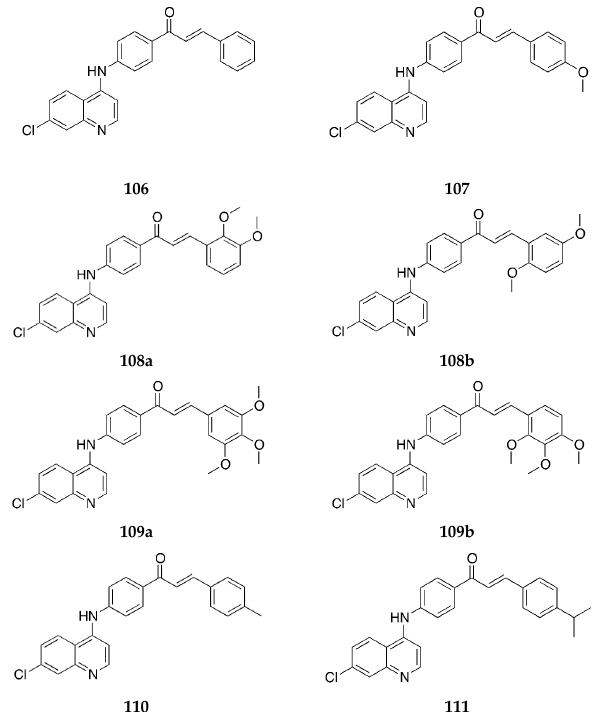
Figure 46. Chemical structures of quinolinyl-4-aminochalcones derivatives. Molecules 2020 , 25 , 5381